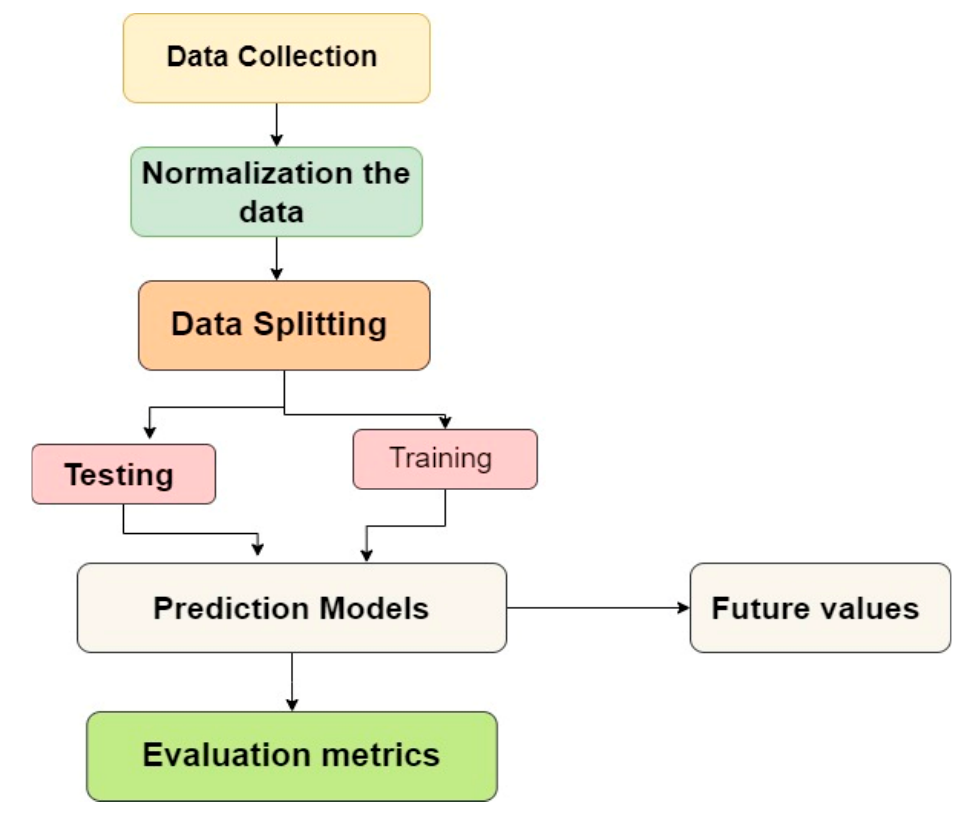
Figure 1. Framework of the proposed system.